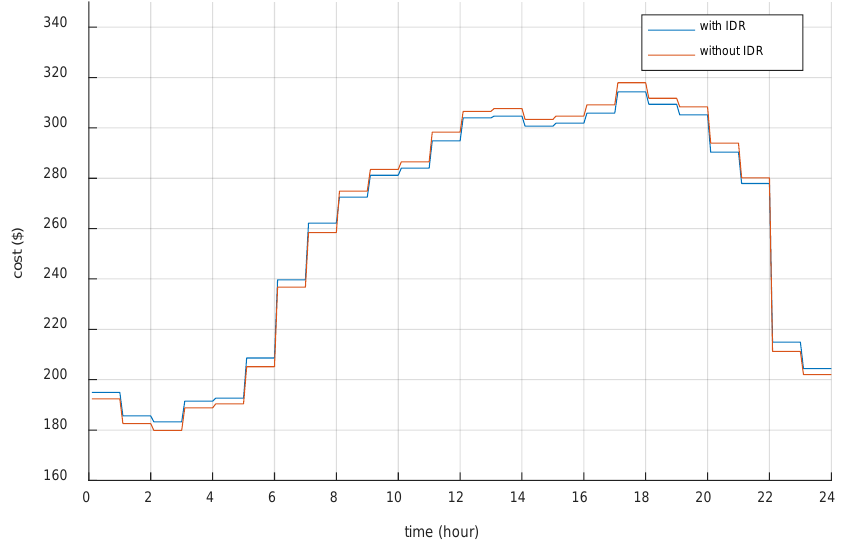
Figure 7. Running costs with and without the IDR.